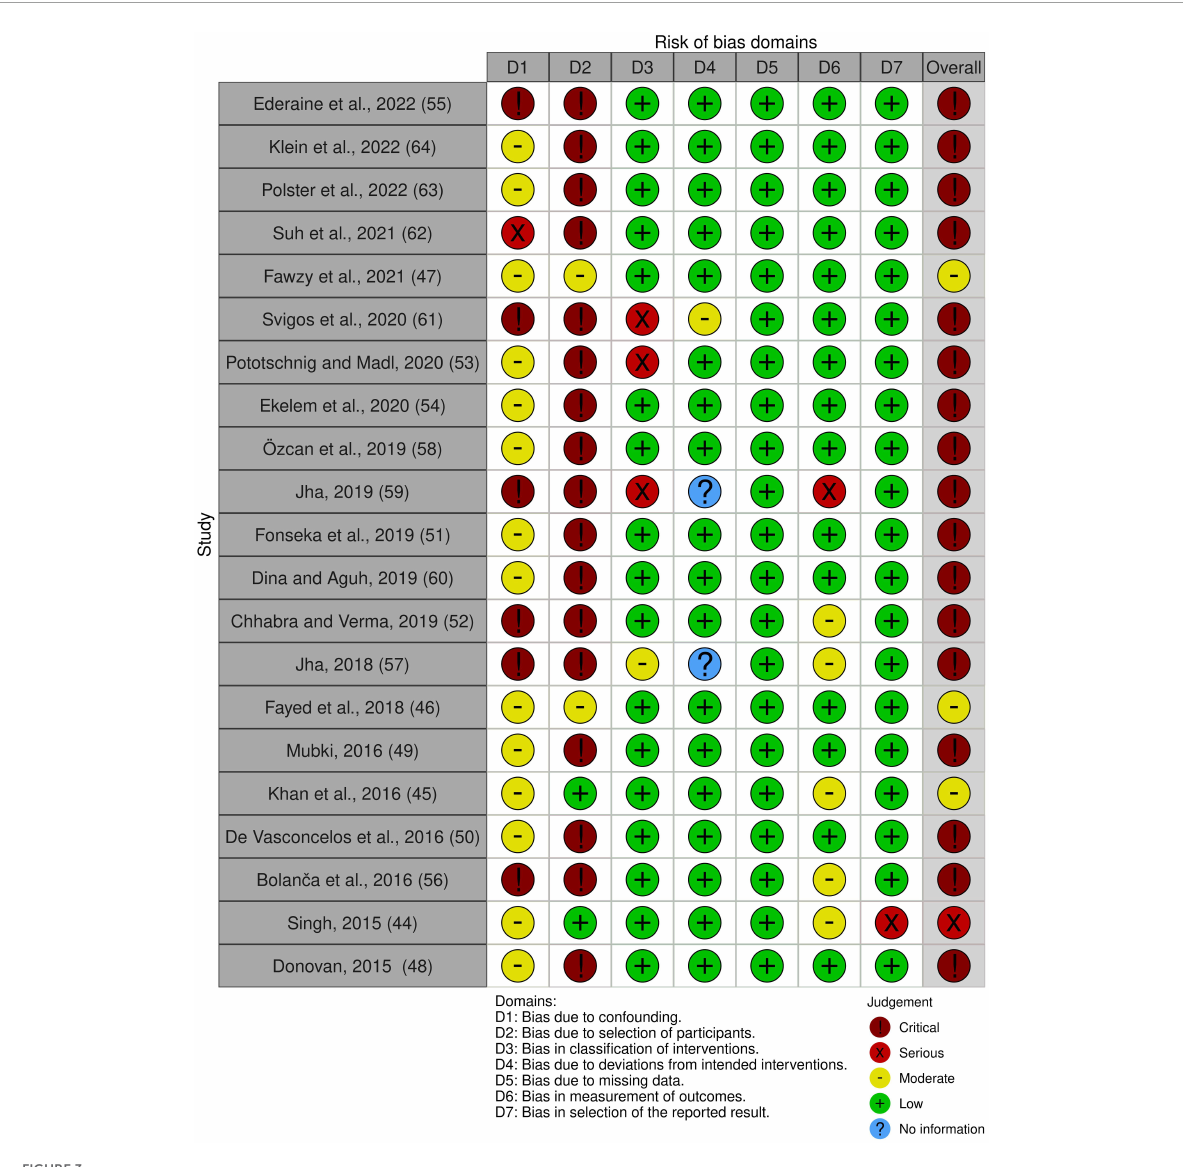
selection bias. All RCTs included were rated as having either low risk or some concerns for overall bias. Risk-of-bias plots are shown in Figures 2 , 3